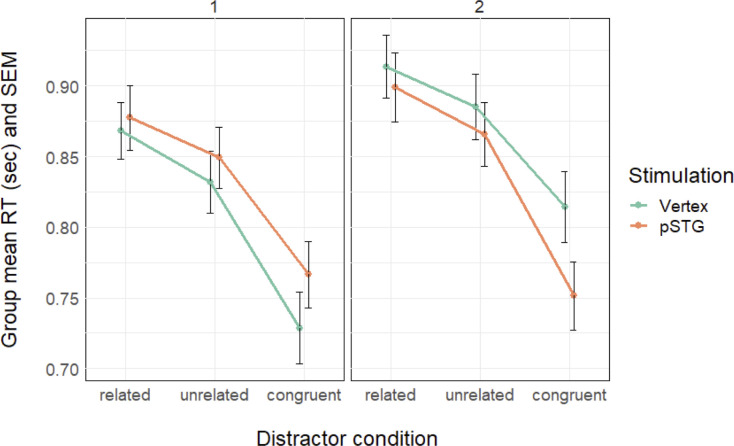
Response time results.Group-level response times (RT), calculated by computing the mean over participant-level means, and standard error of the mean (SEM) for vertex stimulation (green) and posterior superior temporal gyrus stimulation (pSTG, salmon) for list 1 (left) and list 2 (right).